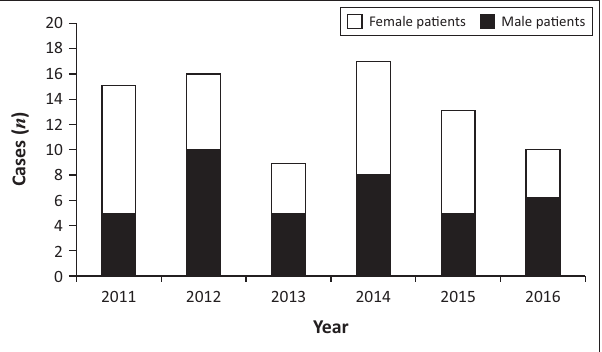
FIGURE 1: Number of incident chronic lymphocytic leukaemia cases by year and gender, 2011–2016.